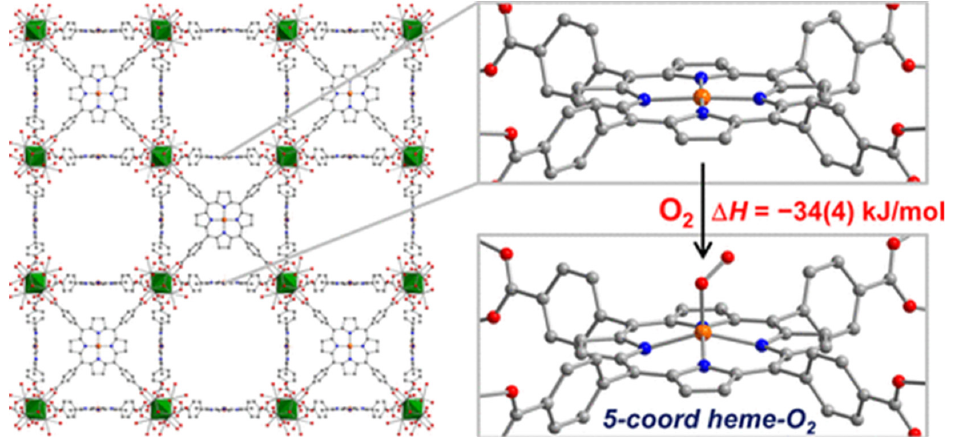
Figure 9. Reaction of porphyrinic MOF, PCN-224Fe II ( 10 ), with O 2 at − 78 °C to generate the first with permission from Ref. [105]. Copyright 2014, American Chemical